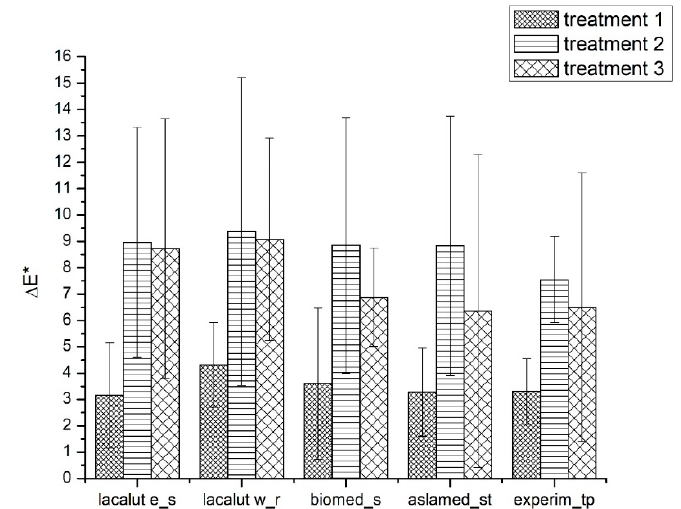
∆ E* during experimental